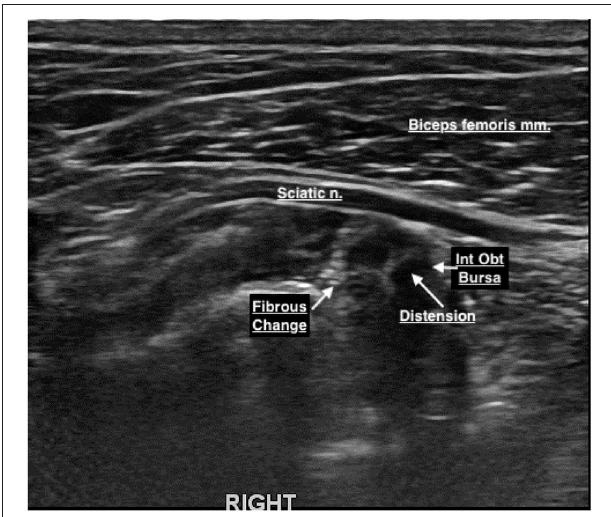
FIGURE 5 | Internal obturator bursa inflammation and fibrous